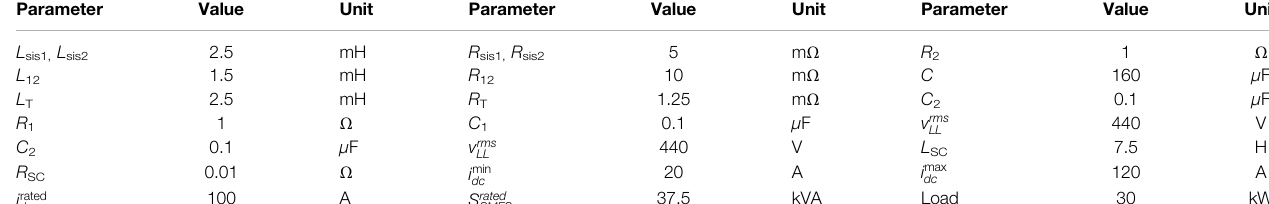
TABLE 1 | The superconducting magnetic energy storage (SMES) system parameters and microgrid parameters.